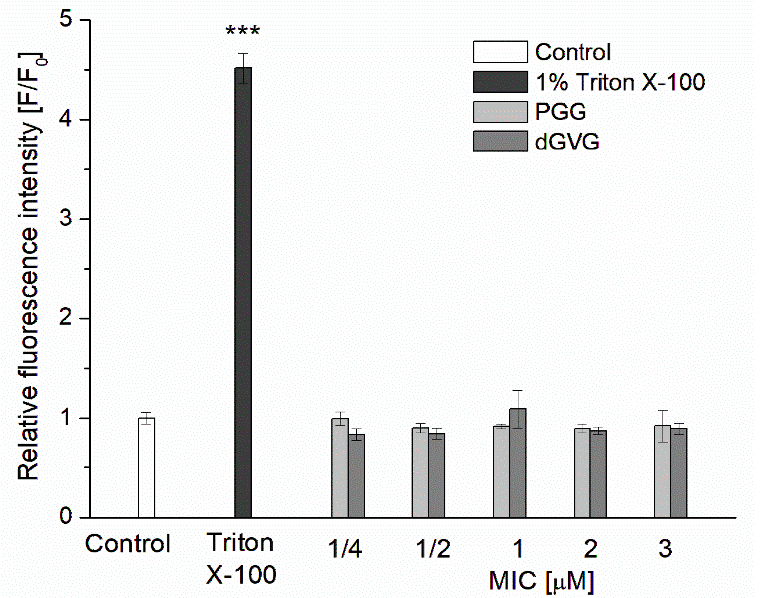
Figure 3. Influence of PGG and dGVG on S. aureus cell membrane integrity. Briefly, 1% Triton X-100 was used as a positive control. Bacterial cells labeled with Sytox Green in the presence of PGG and dGVG in the concentration range of ¼ x MIC to 3 x MIC, which corresponds to 20 μ M, 40 μ M, 80 μ M, 160 μ M, and 240 μ M for PGG and 75 μ M, 150 μ M, 300 μ M, 600 μ M, and 900 μ M for dGVG. The data presented are the means ± SD, n = 6. Statistical significance was estimated using a one-way ANOVA test (results compared to control, *** p < 0.001).